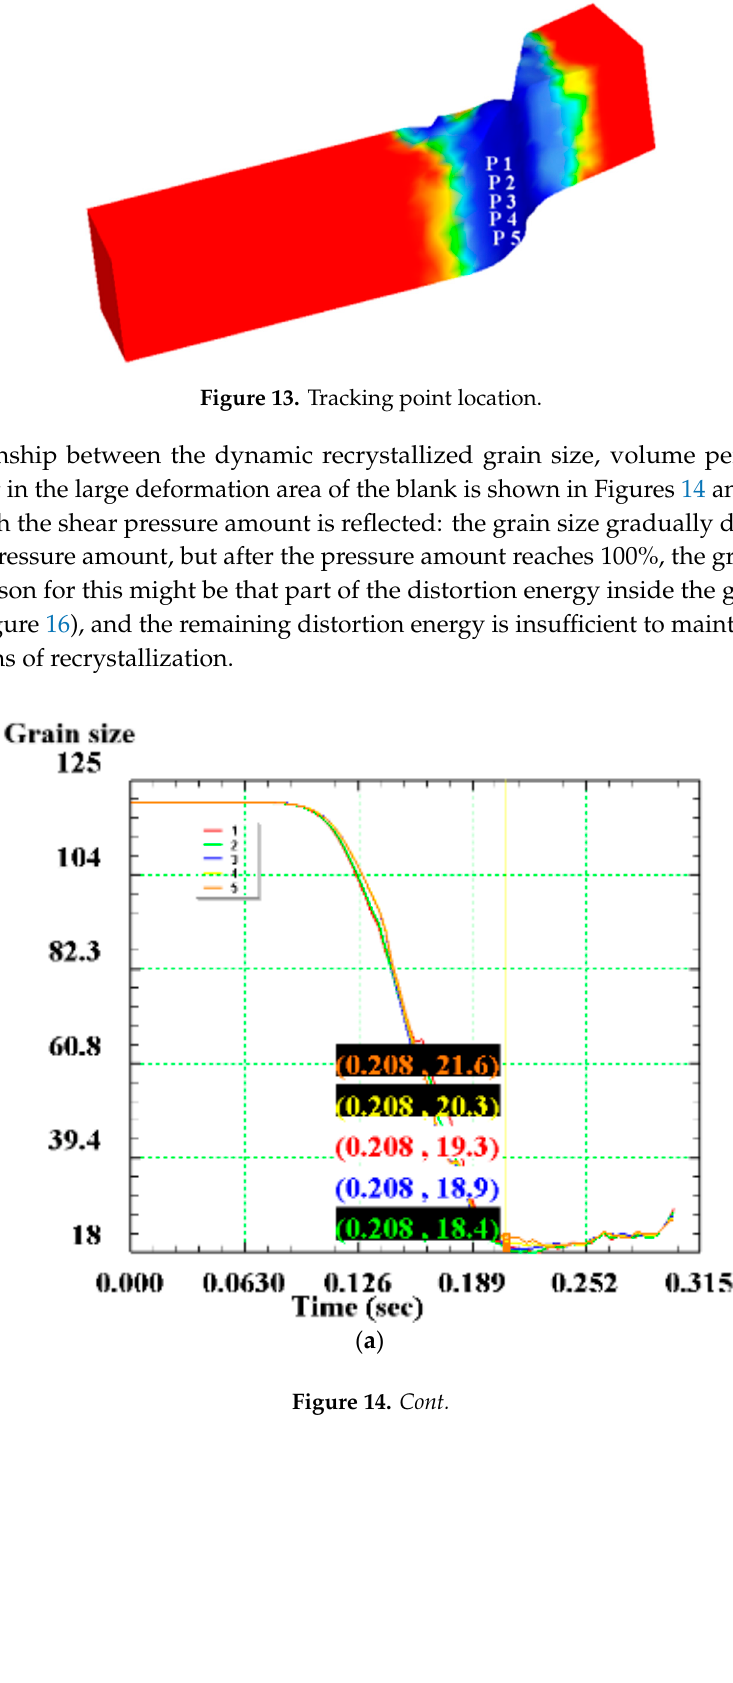
Figure 12. Dynamic recrystallization volume percentage: ( a ) L = 100%; ( b ) L = 125%; ( c ) L = 150%.